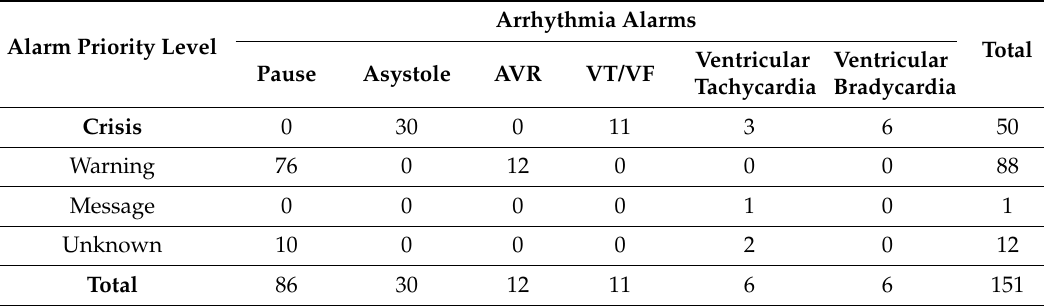
Table 2. Arrhythmia Alarms Priority Level (n=151 alarms)